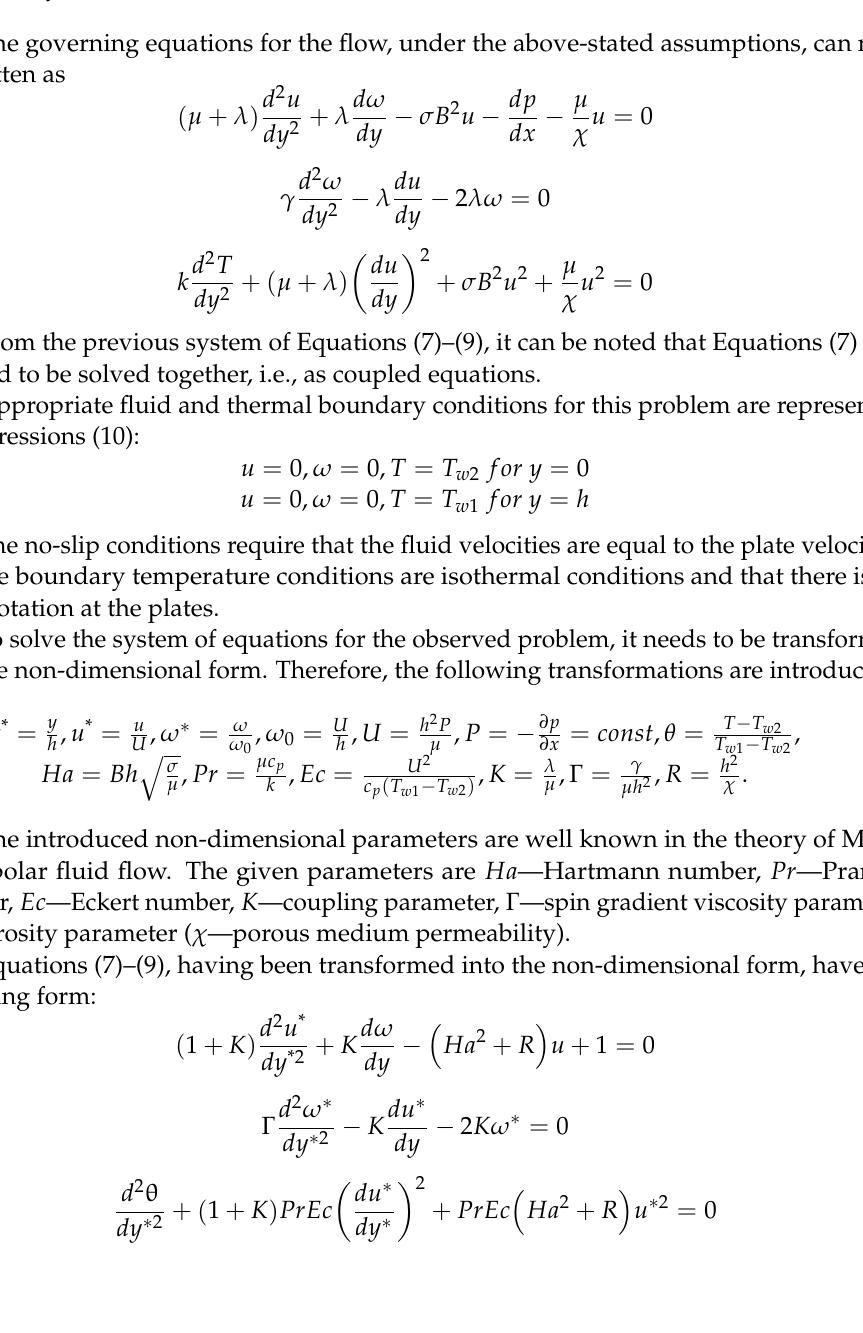
Figure 1. Physical model.